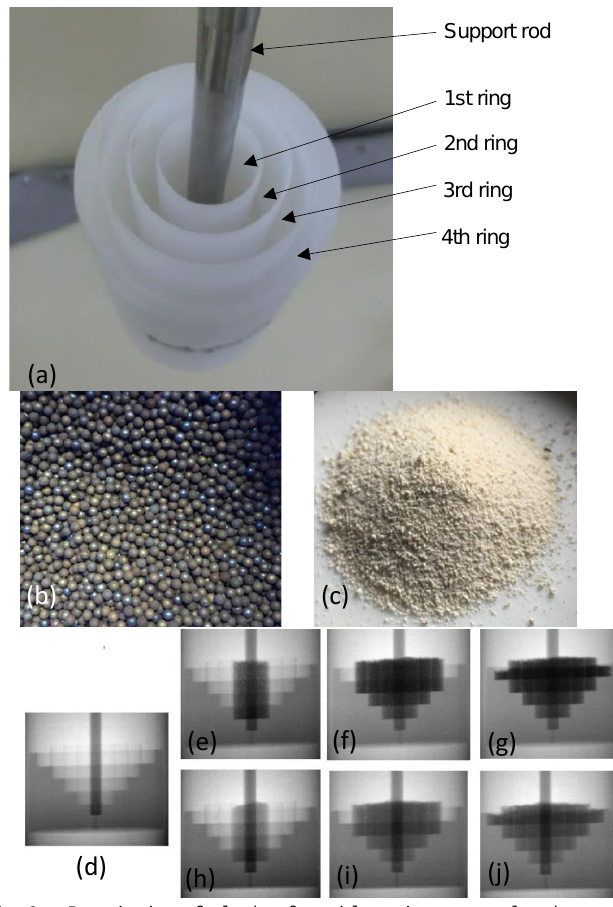
Fig. 8. Investigation of clouds of particles using an annular phantom (reproduced from [12] with permission) including (a) the phantom model, (b) 4 mm diameter steel balls, (c) fine HfO 2 powder, and X-ray images of (d) the empty phantom, the phantom with (e-g) 1, 3 and 4 rings filled with steel balls, and (h-j) 1, 3 and 4 rings filled with HfO 2 powder.